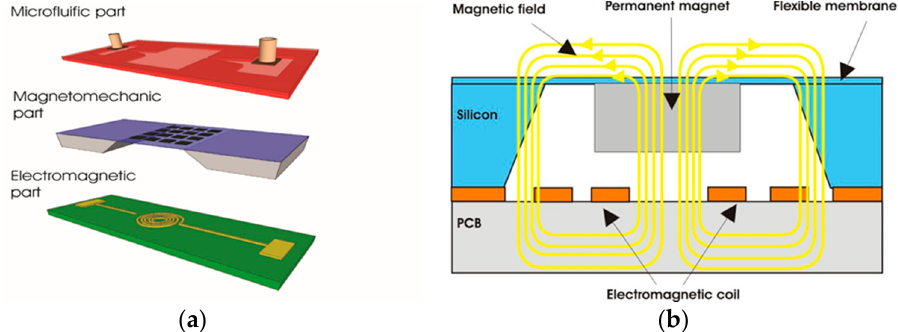
Figure 1. Schematic pictures of the designed valveless electromagnetic (EM) micropump system components: ( a ) the structure of the micropump system; ( b ) the mechanism of electromagnetic actuation.